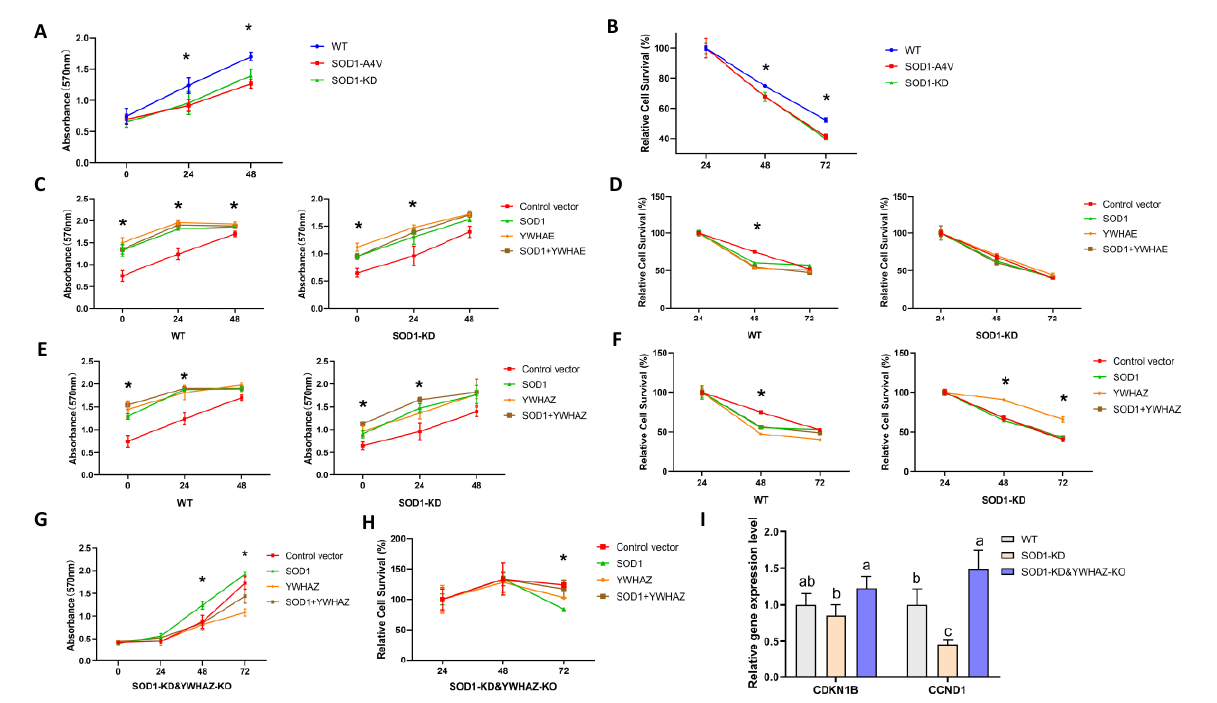
Figure 6. Impacts of altering protein–protein interactions between SOD1 and YWHAE or YWHAZ on cell growth and survival of HEK293T cells. ( A ) Proliferation curves in WT, SOD1A4V, and SOD1-KD HEK293T cells. ( B ) Survival curves of WT, SOD1A4V, and SOD1-KD HEK293T cells after the removal of FBS in culture media. ( C ) Proliferation curves of WT and SOD1-KD cells overexpressing SOD1 and YWHAE alone or in combination supplemented with FBS culture media. ( D ) Survival curves of WT and SOD1-KD cells overexpressing SOD1 and YWHAE alone or in combination after the removal of FBS in culture media. ( E ) Proliferation curves of WT and SOD1-KD cells overexpressing SOD1 and YWHAZ alone or in combination supplemented with FBS culture media. ( F ) Survival curves of WT and SOD1-KD cells overexpressing SOD1 and YWHAZ alone or in combination after the removal of FBS in culture media. ( G ) Proliferation curves of SOD1-KD&YWHAZ-KO cells overexpressing SOD1 and YWHAZ alone or in combination supplemented with FBS culture media. ( H ) Survival curves of SOD1-KD&YWHAZ-KO cells overexpressing SOD1 and YWHAZ alone or in combination after the removal of FBS in culture media. ( I ) Relative mRNA levels of cell proliferation genes in SOD1-KD and SOD1-KD&YWHAZ-KO cells compared with WT cells. *: The asterisks above curves indicated that the SOD1A4V and SOD1-KD were significantly different from the WT in ( A , B ). In ( C – H ), the asterisks indicated that at least one treatment group was significantly different from the negative control (F1N + F2N), p < 0.05, n = 4. Means for a given gene (I) without sharing a common letter differ ( p < 0.05).